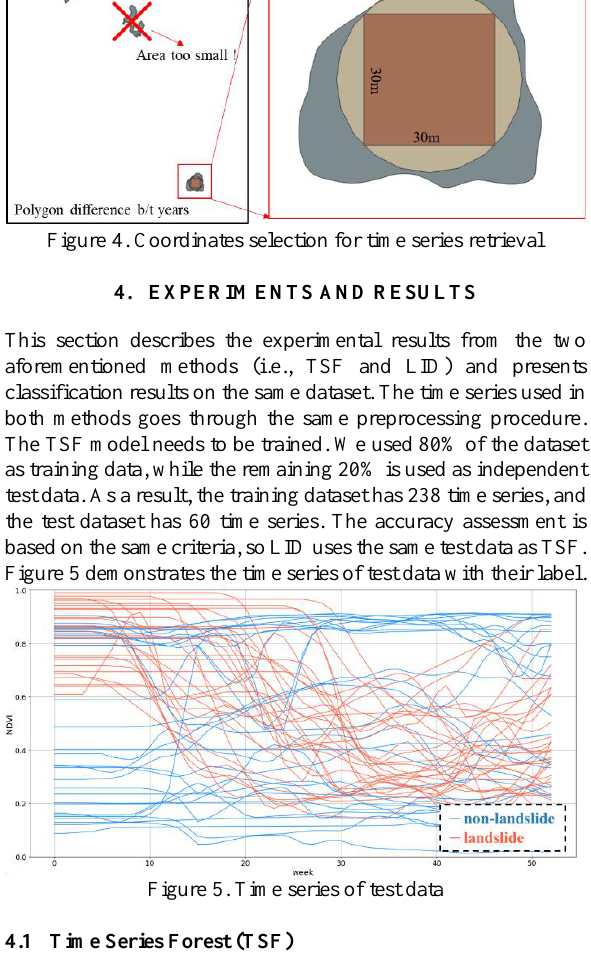
Figure 6. Confusion matrix of TSF